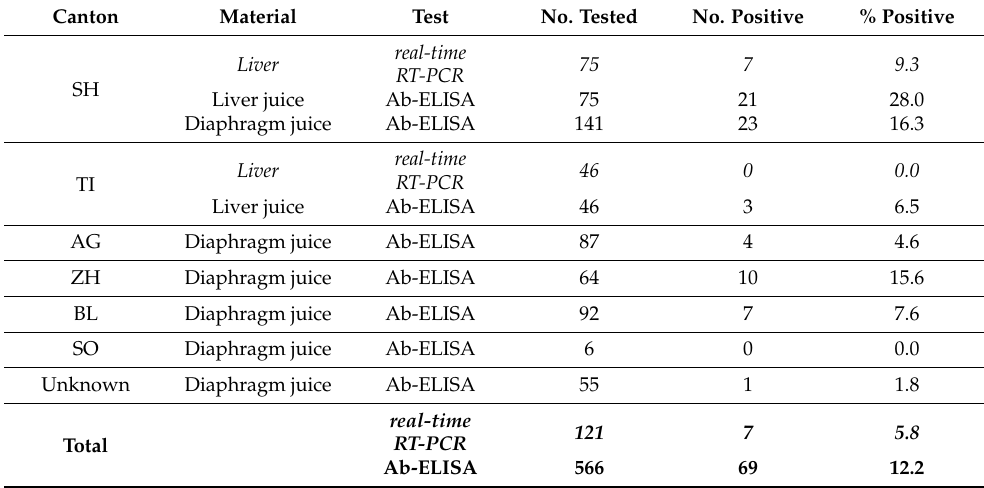
Table 1. HEV real-time RT-PCR (italic) and antibody ELISA results of wild boars from different Swiss cantons. Schaffhausen = SH, Ticino = TI, Aargau = AG, Zurich = ZH, Basel-Landschaft = BL, Solothurn =